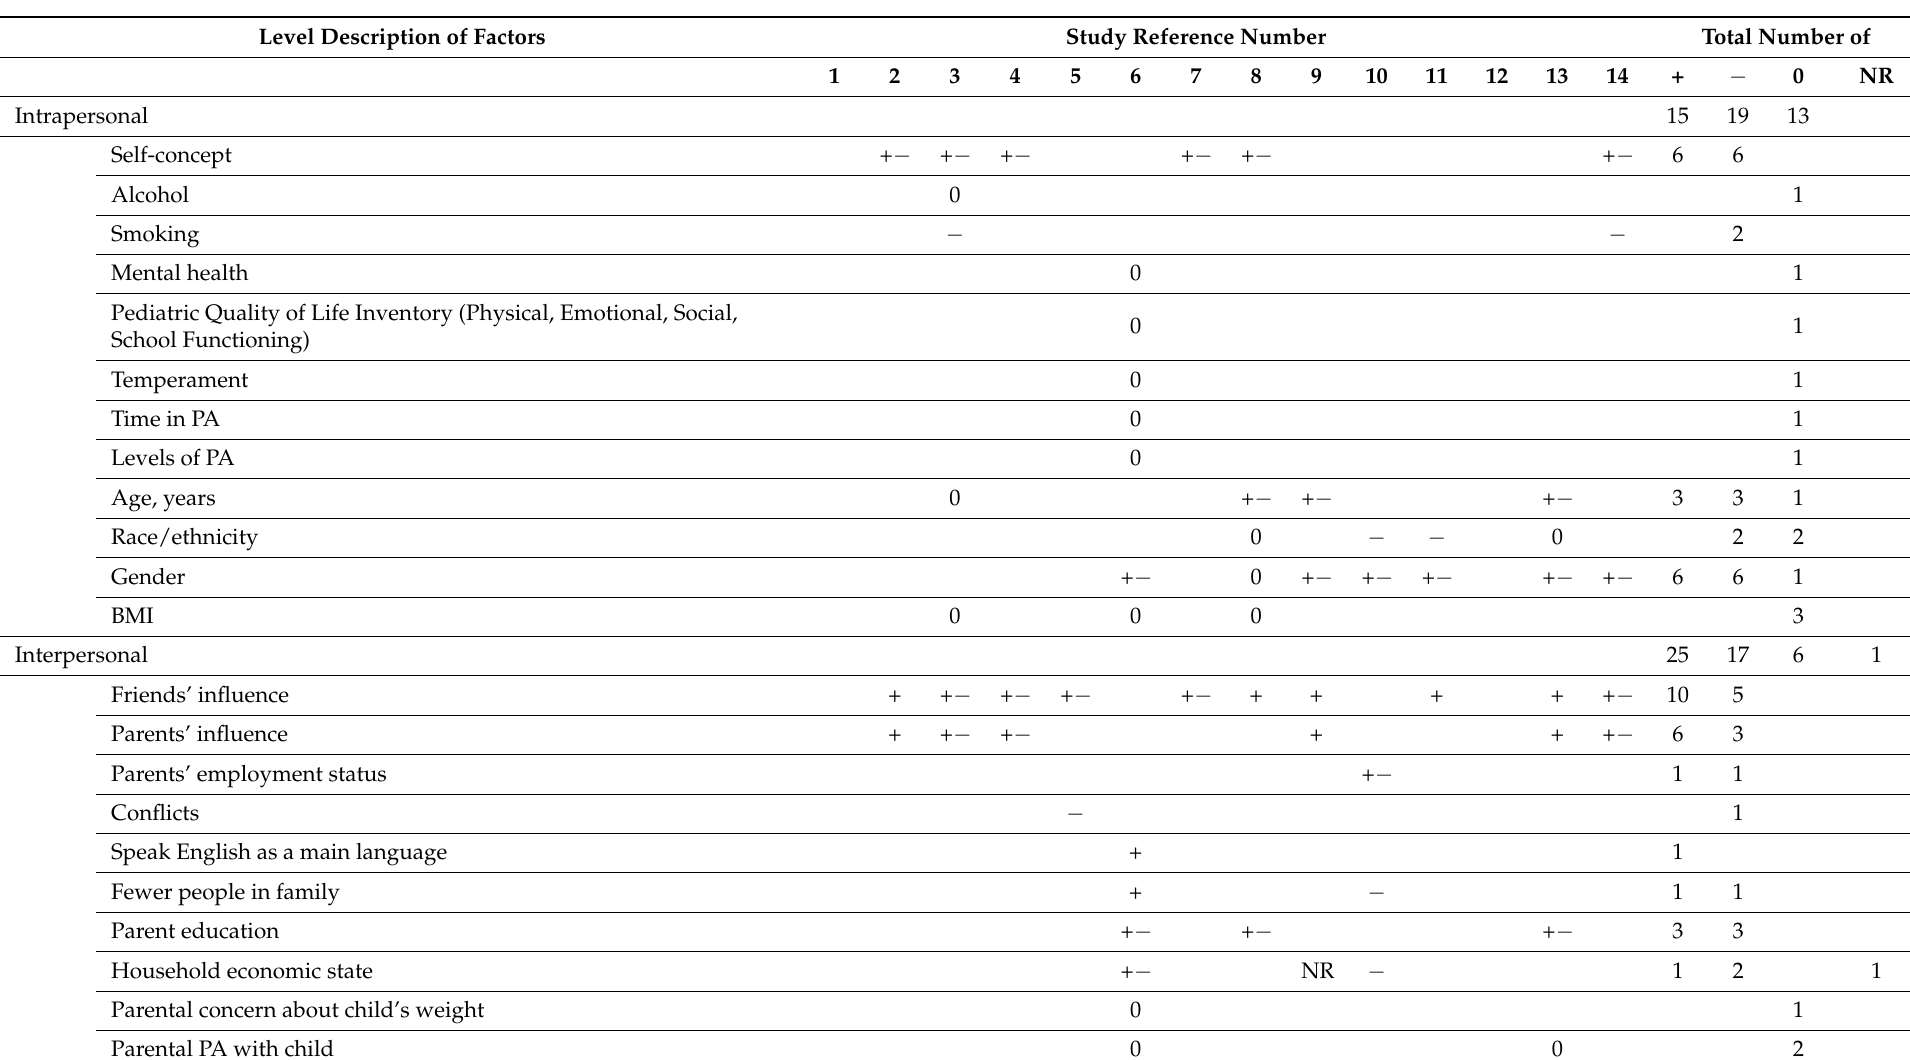
Table 1. The factors that influence participation in physical activity in children and adolescents in the social ecological model proposed by McLeroy et al. (1988) [16]. Level Description of